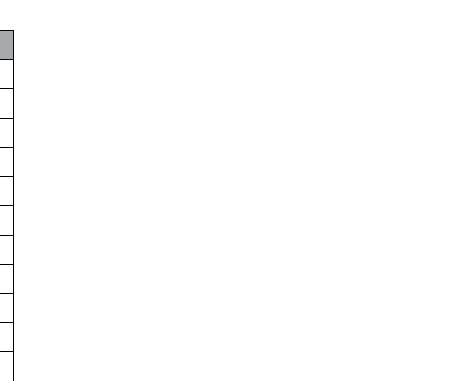
Table 2. Environmental description of the experimental site. FTM Field ten main season, FTO Field ten off season, FFM Field fifteen main season, FFO Field fifteen off season, ENV. Environment, Main season May– September, Off season November–March, Av. Temp. Average temperature, Av. Hum. Average humidity. Sources: https:// en. clima te- data. org/ asia/ malay sia/ selan gor/ mardi- serda ng- 97161 3/# clima te- table.